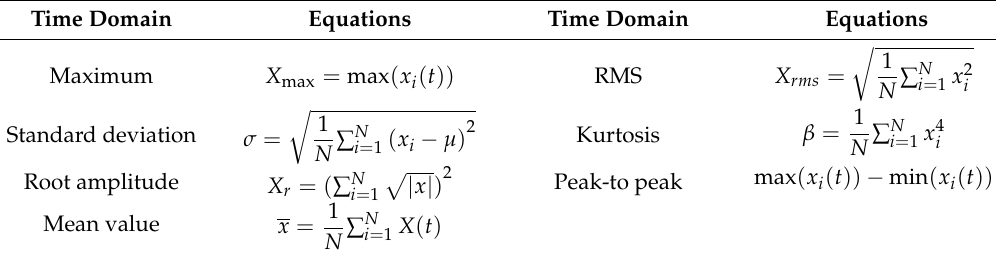
Table 3. Statistical features of the TC signal in time